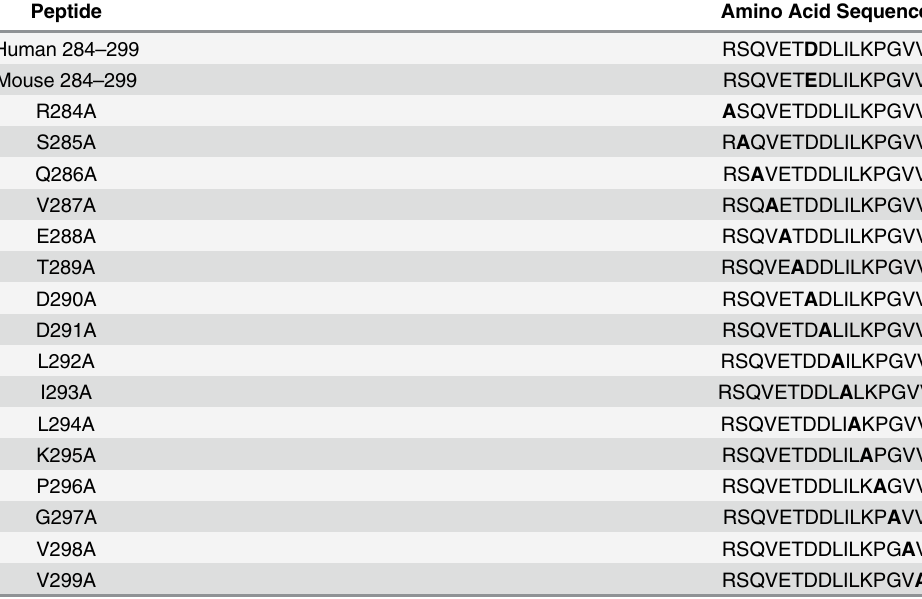
Table 1. Human (h)AQP4 284-299 Alanine Scanning Peptides. The immunogenic region of hAQP4 281-300 , hAQP4 284-299 , was utilized to generate alanine scanning peptides at which each peptide sequence has a sin- gle alanine residue mutation.